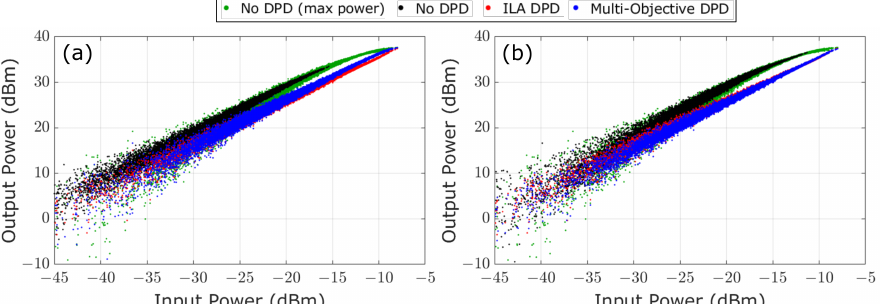
Figure 9. AM/AM characteristics obtained with the proposed multi-objective optimization (blue), compared with the classical ILA approach (red) and the case without DPD (black). ( a ) same level of ACPR (cid:39) − 33 dB, corresponding to the intercepts of the vertical dashed line in Figure 6a; ( b ) same level of ¯ P OUT (cid:39) 0.7 W, corresponding to the intercepts of the horizontal dashed line in Figure 6a. Green lines show the maximum output power performance without DPD at − 4 dB compression ( ¯ P OUT (cid:39) 1.3 W, ACPR (cid:39) − 27 dB).